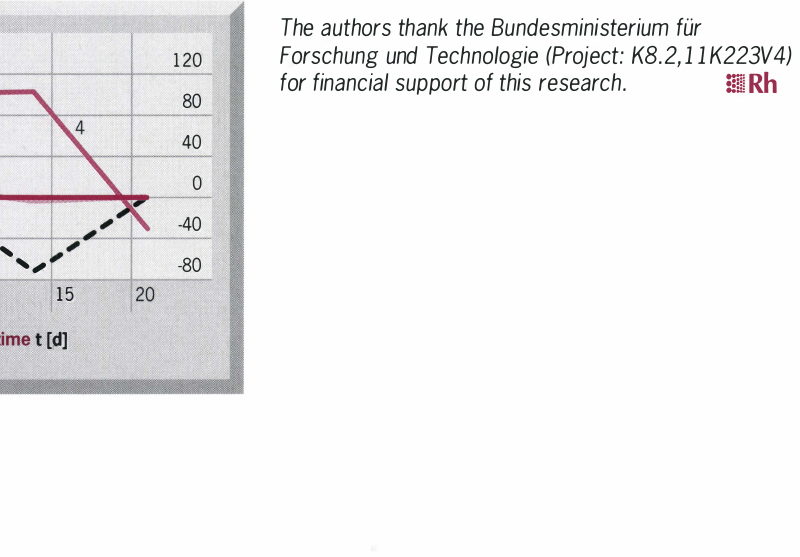
Thixotropiefliichen von scher­ geschwindigkeitsgesteuerten Flieflkurven bei 25 o c fur Probe 4 nai:h Zusatz ver­ schiedener Mengen NaNOz (in moljkg)